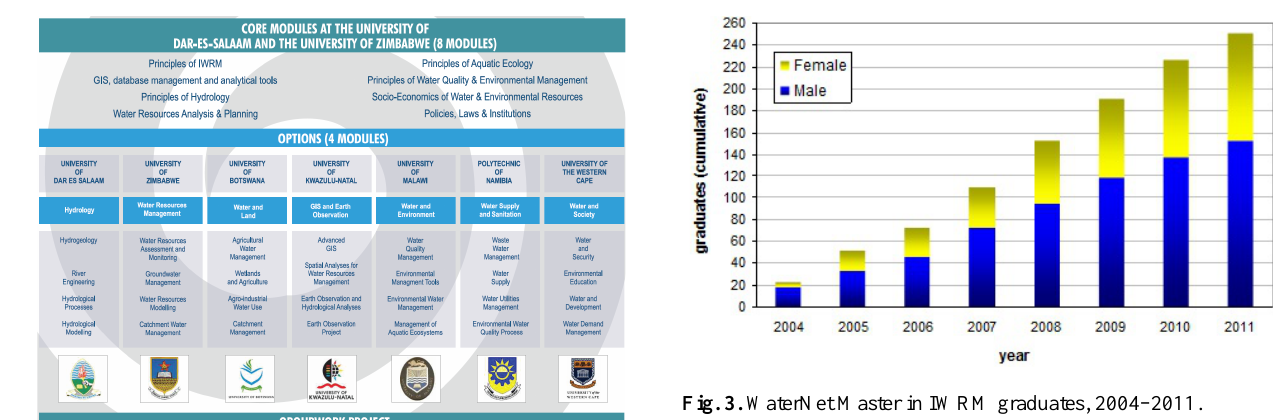
Fig. 3. WaterNet Master in IWRM graduates, 2004–2011.